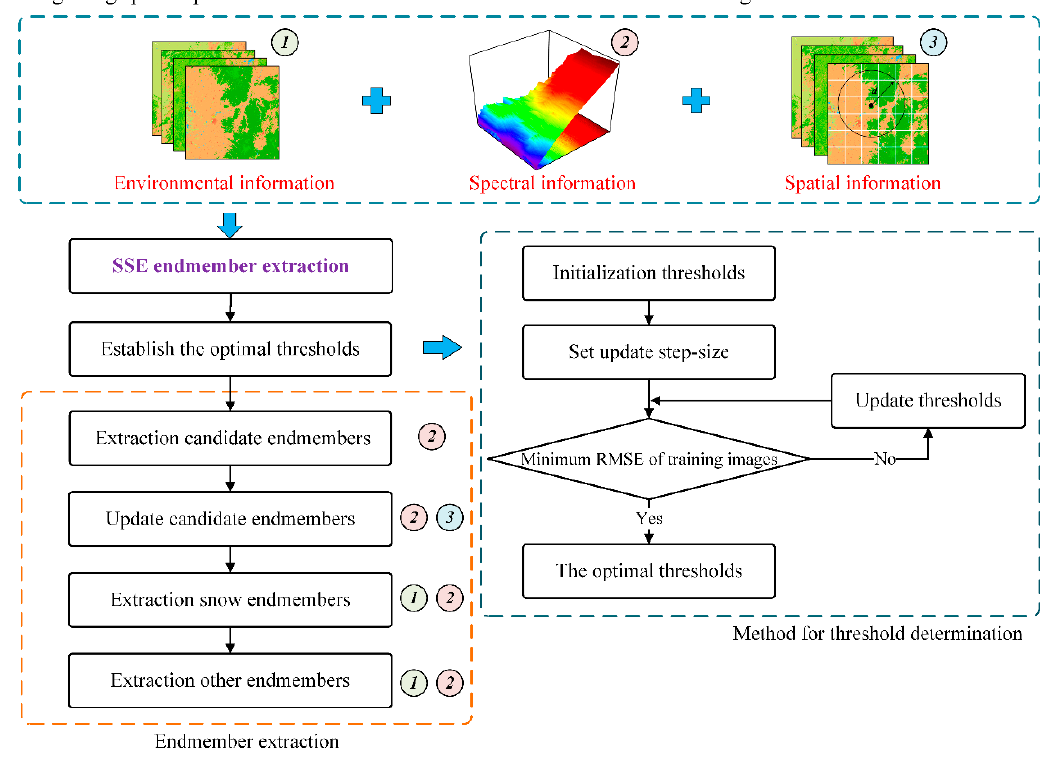
Figure 2. The diagram of the processing flow for SSE endmembers extraction. The trial-and-error method is utilized to obtain optimal thresholds. Numbers 1, 2, and 3 denote spatial, spectral, and environmental information, respectively. The digital label in the endmember extraction indicates which one of the three different information types is introduced. For example, number 2 after “Extraction candidate endmembers” indicates that spectral information was adopted in this step.